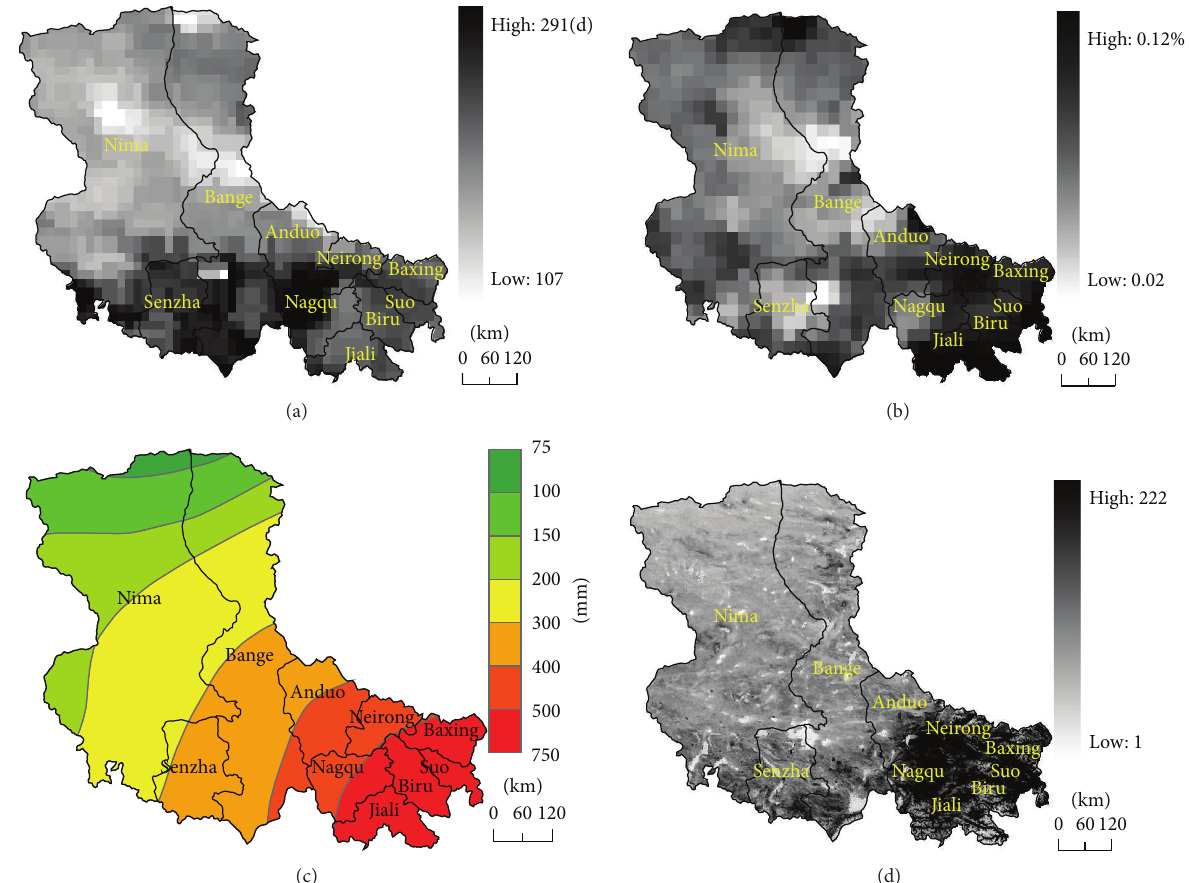
Figure 2: Distribution maps of annual FT cycle days (a), average diurnal phase-changed water content (b), average annual precipitation (c), and vegetation coverage